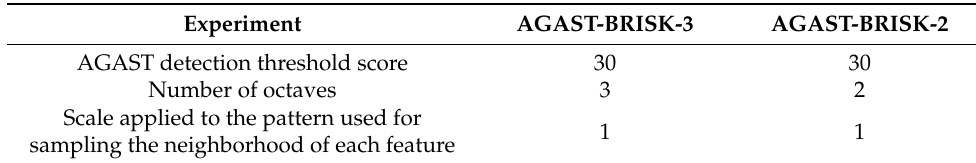
Table 4. Parameterization evaluated in the experiments performed using the AGAST detector and the BRISK descriptor.